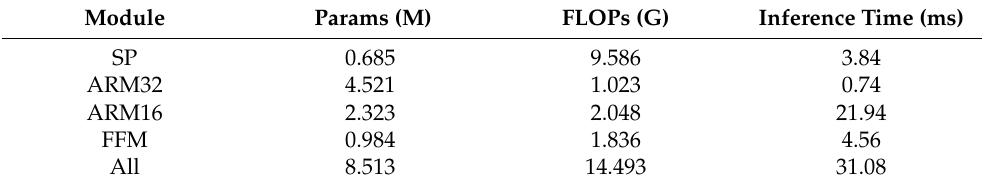
Table 1. Analysis of the Number of Parameters, Number of Computations and Inference Time of the BiSeNet